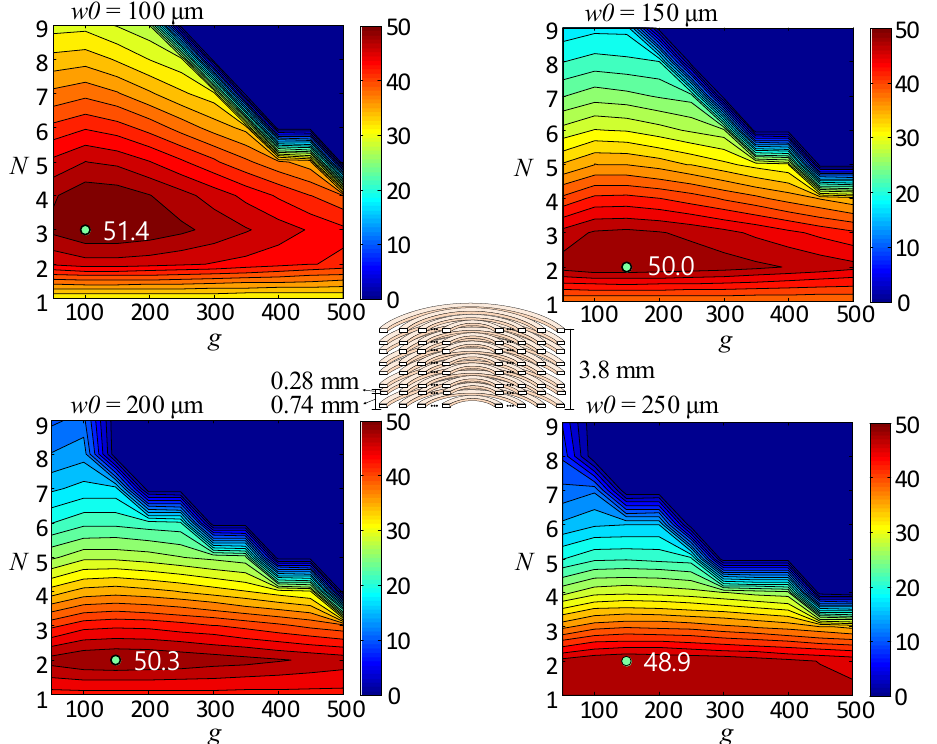
Figure 9. The calculated Q-factor according to g and N for the eight-layer planar spiral coil for w 0 = 0.1, 0.15, 0.2, and 0.25 mm.